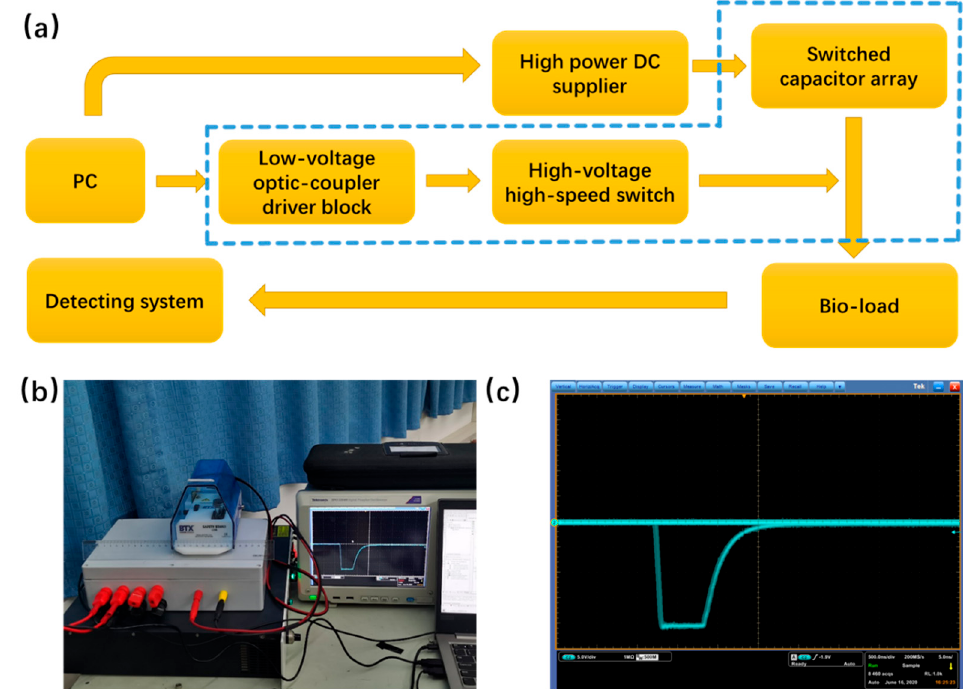
Figure 3. ( a ) Schematic diagram of the pulse generator built in seven modules; ( b ) the image of the experimental setup; ( c ) an example of the images of measure results (300 pulses with the pulses width of 500 ns on the swine tissue load).